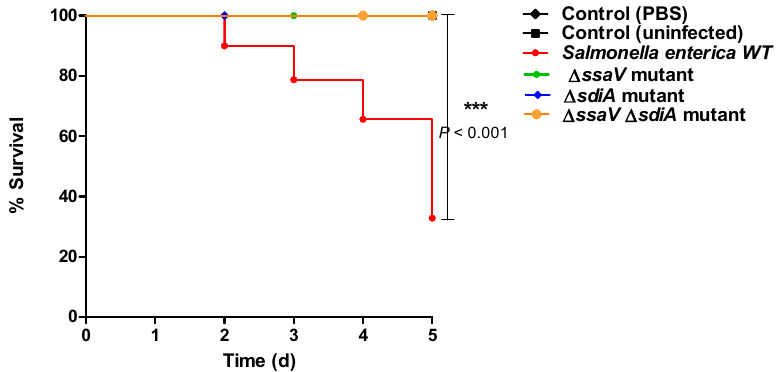
Figure 8. Mutation of S. enterica sdiA and/or ssaV genes significantly reduced bacterial virulence in mice. Mice (n = 10 mice/group) were injected with 100 µL of bacterial cells (2 × 10 6 CFU/mL) of S. Typhimurium WT, Δ ssaV , Δ sdiA or Δ ssaV Δ sdiA strains. No death was reported for mice in negative controls, either uninfected or injected with PBS. Similarly, all mice survived in groups injected with